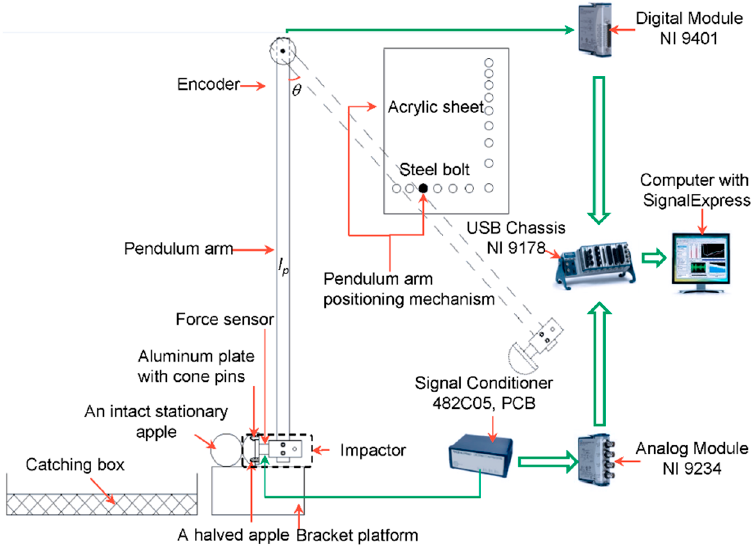
Figure 1. A schematic presentation of the pendulum-type impact test device used in this study. In the diagram, l p and θ was separately the pendulum arm length and the pendulum’s angle relative to the vertical axis. For specification of the test procedures with the impact device, please see Section 2.2.